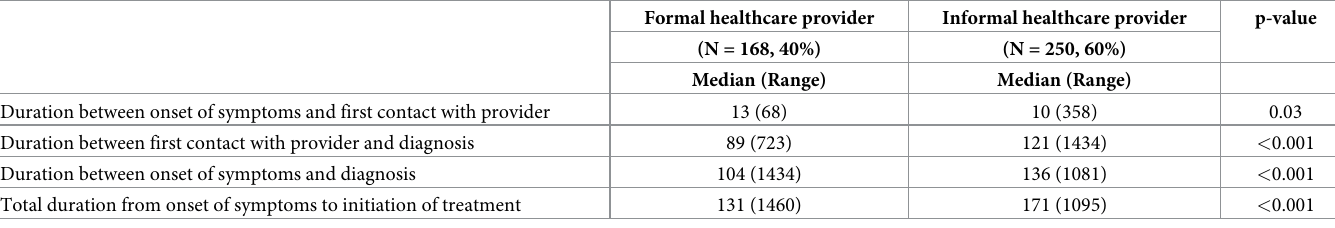
(median 107 days). The shortest duration was observed between diagnosis and referral for treatment (median 3 days) and onset of symptom to first contact with any healthcare provider (median 10 days) (Fig 1). Table 6. Duration of intervals (days) in care seeking with first point of contact � . Formal healthcare provider Informal healthcare